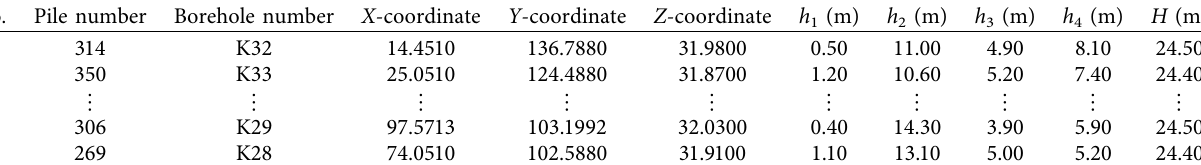
Table 2: 10 groups of data for prediction.